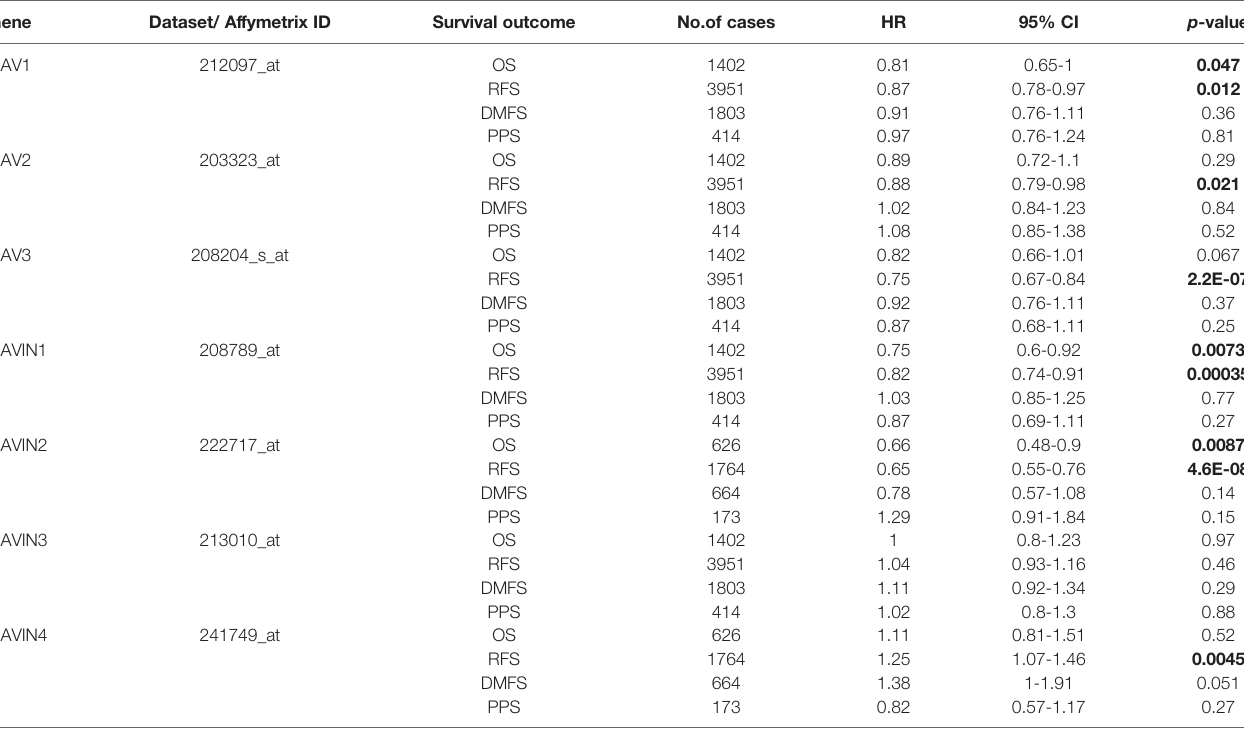
Bold values mean p value less than 0.05.